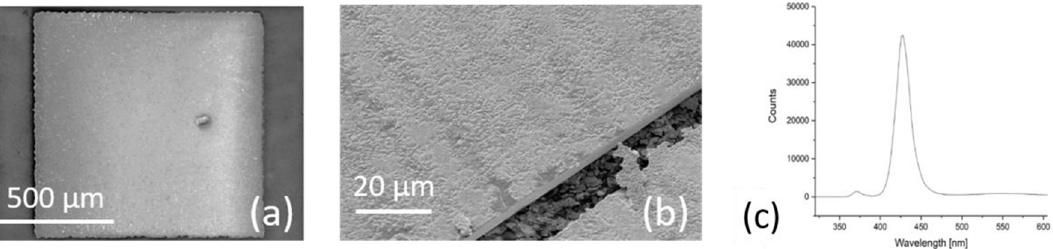
Figure 3. SEM images of a lifted LED chip, applying the 520 nm femtosecond laser. ( a ) Crack-free substrateless LED with 1 × 1 mm in size, ( b ) closer view on the n -GaN surface of another sample where the crack occured during mounting of the structure onto a carbon pad, ( c ) cathodoluminescence spectrum clearly revealing the quantum well emission around 430 nm.